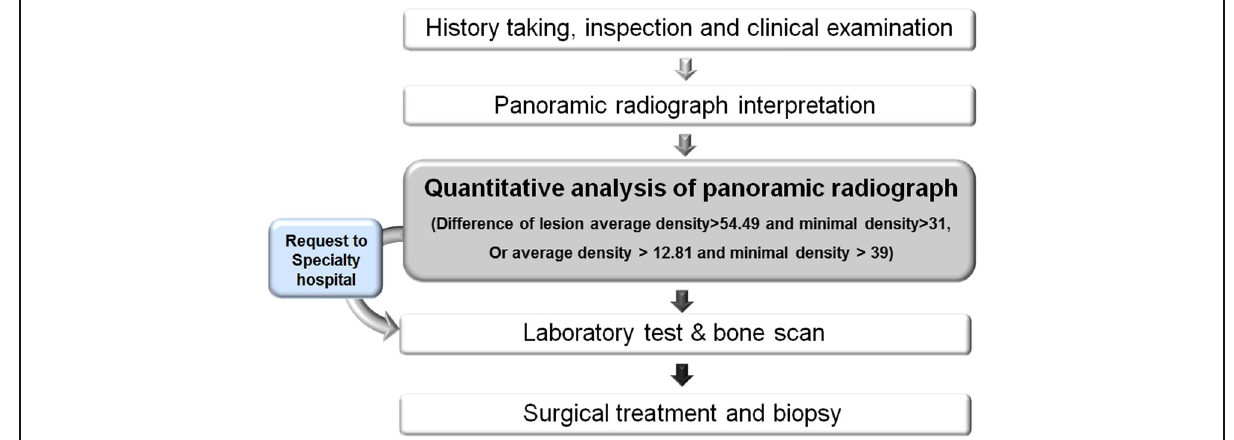
Fig. 4 Diagnosis model using quantitative analysis of panoramic radiograph in jaw osteomyelitis suspicious